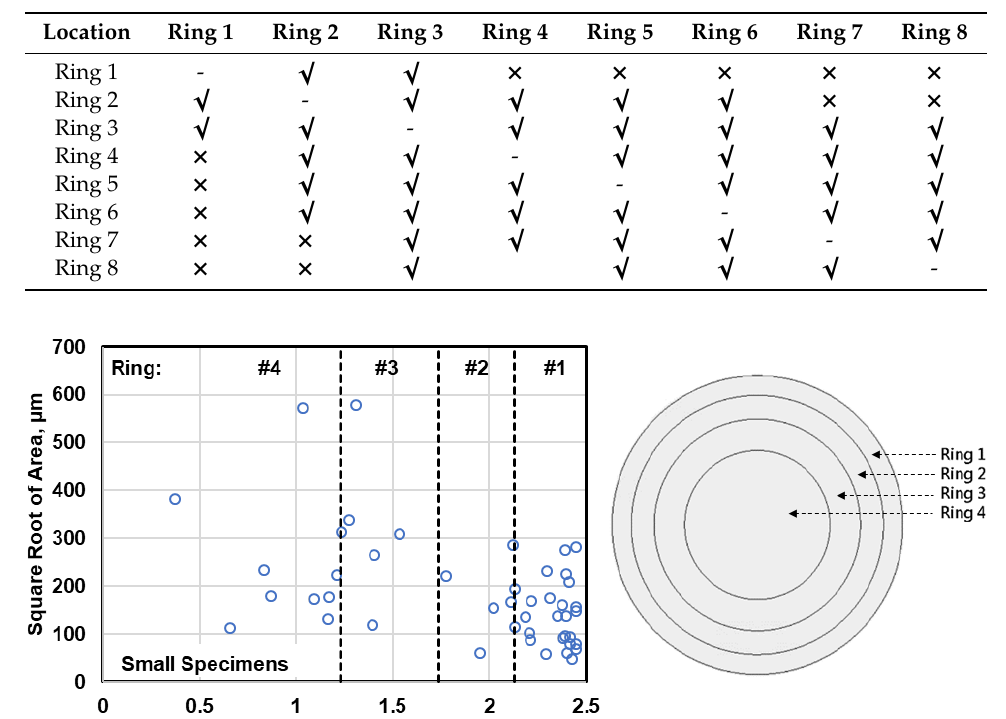
Table 4. K-S test results for comparing defect distribution in large specimens at different “Rings” using CT scan data.